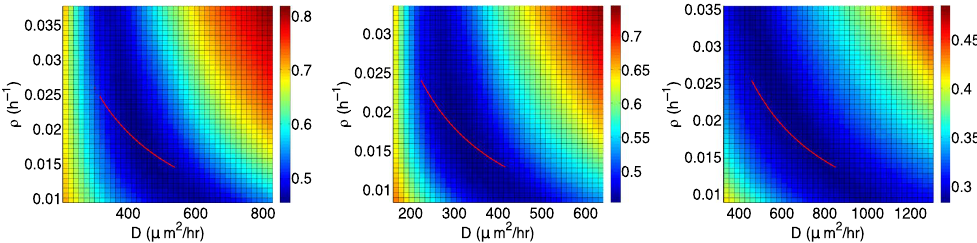
Figure 4. Plots of E ( D , ρ ) (equation (4)) for Hypothesis 1 for Mouse 1 (left), Mouse 2 (center), and Mouse 3 (right) for selected intervals of the model parameters D and ρ . The red line represents the wave speed, ρ D 2 , for the “optimized” values of D and ρ